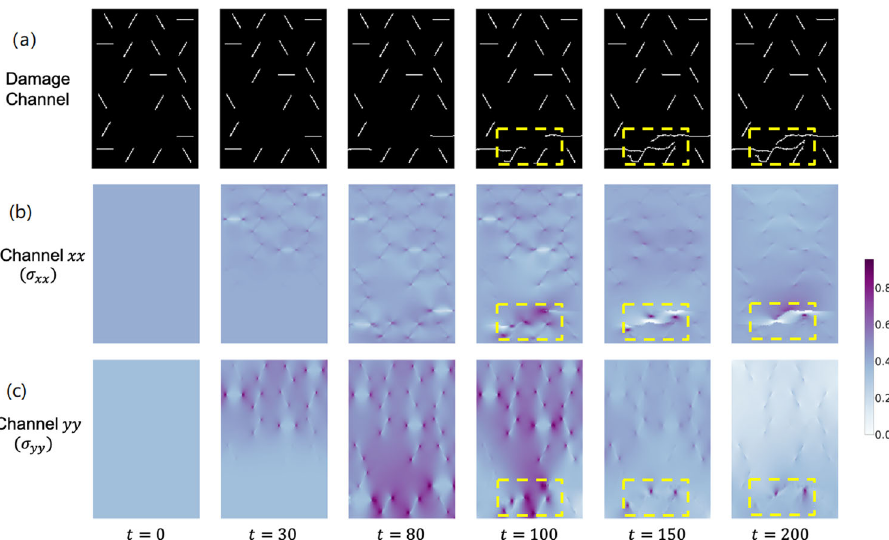
Fig. 2 Visualization of the fracture growth and the dynamic changes of the stress fi eld in two directions. a is the propagation of cracks and the simulation ends when a single crack spans the width of the material, which is shown in the yellow-highlighted region. The white lines represent cracks and the black background represents the normal material. b represents the stress fi eld of σ xx and ( c ) represents the stress fi eld of σ yy . According to the yellow dashed boxes highlighted in this fi gure, the stress tends to concentrate on the tips of existing cracks, and moreover, the cracks will grow because of the stress